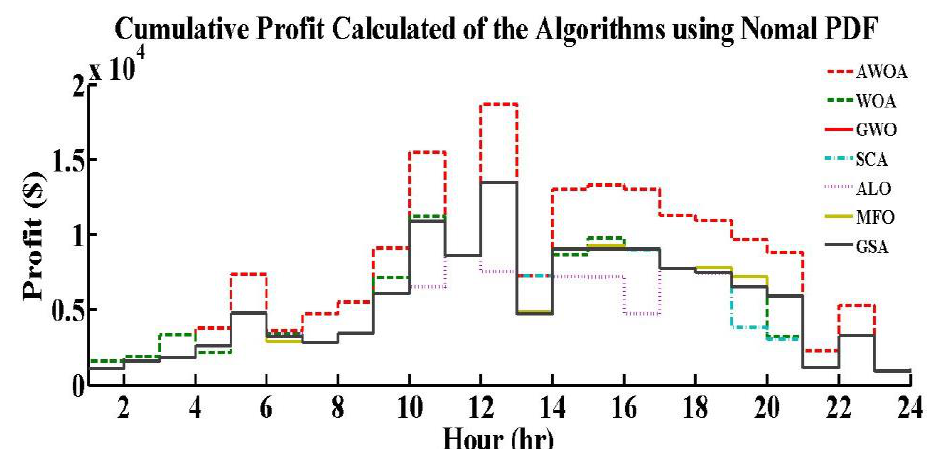
Figure 10. Cumulative Profit Calculated of the Algorithms using Normal PDF.